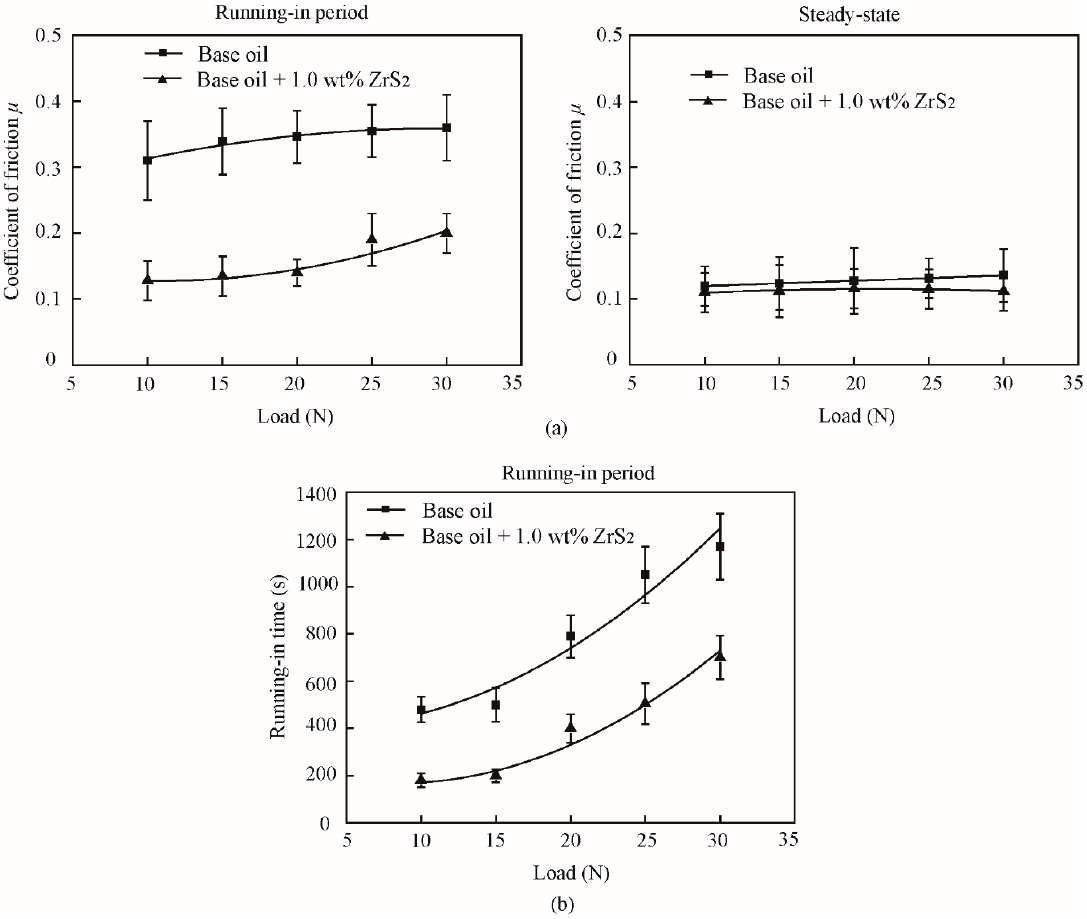
Figure 15. ( a ) Average friction coefficient and ( b ) running-in time of the base oil and that with 1.0 wt% ZrS 2 nanobelt additives under different normal loads.